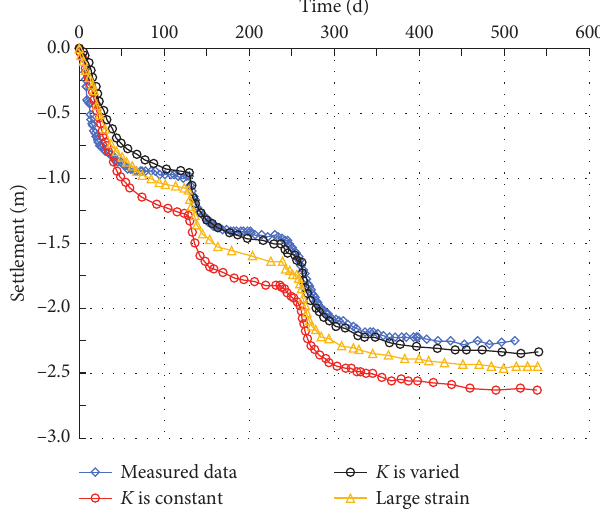
Figure 6: Comparison of the settlement monitoring values and the numerical calculation results (Point ( B